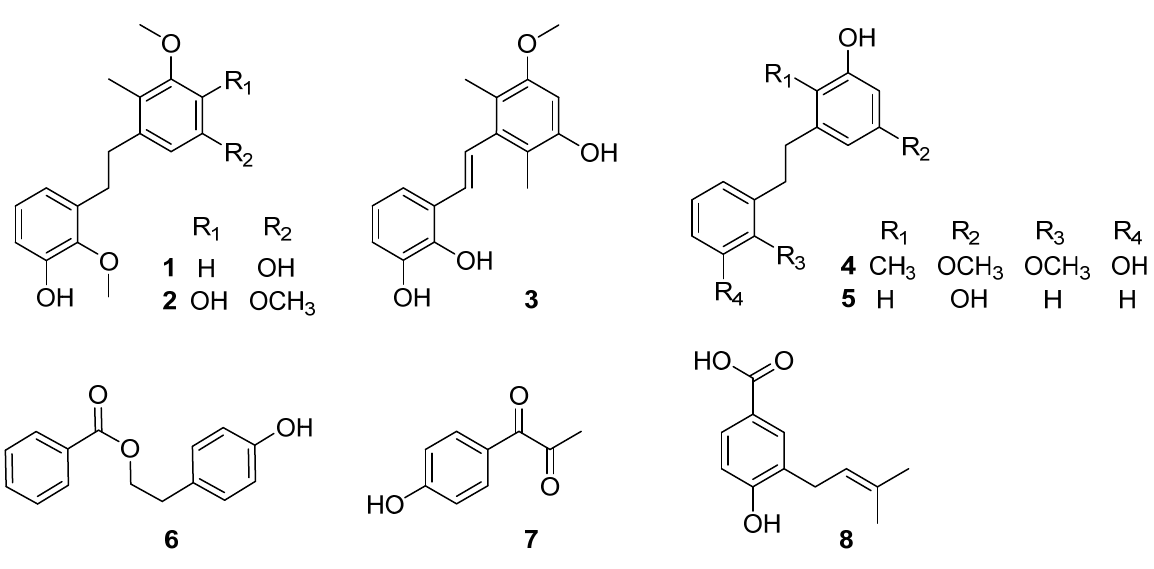
Figure 1. The chemical structures of compounds 1 – 8 obtained from the tuber of A. cochinchinensis.